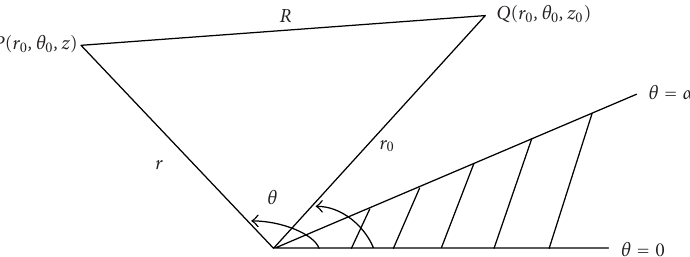
Figure 2.1. The z -axis lies along the edge of the wedge. The radial distances r and r 0 lie in a plane perpendicular to the z -axis. The distance R = { r 2 + r 2 0 − 2 rr 0 cos( θ − θ 0 ) + ( z − z 0 ) 2 } 1 / 2 lies between the point P in the plane z = z and Q in the plane z = z 0